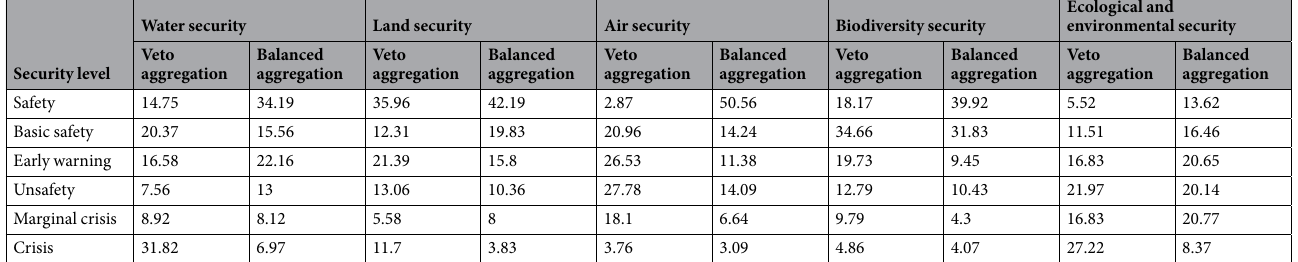
aggregation and 71.75% by the balanced aggregation method (Table 1). Area proportions at the marginal crisis and crisis classes are 9.79% and 4.86% by the veto aggregation, compared to the 4.30% and 4.07% areas by the bal- anced aggregation method (Table 1). Areas at the danger level present a relatively scattered distribution, including the Hengduan Mountains in southwestern China, hills in southern Yunnan Province, adjacent Mountains of Chongqing Municipality and Hubei Province, adjacent Mountains of Zhejiang Province and Fujian Province, the Nanling Mountains in southeastern China. Ecological and environmental security evaluation. Figure 2 shows the final ecological and environ- mental security evaluation in terrestrial ecosystems of China. With different strategies and emphases of two meth- ods, different numerical values and spatial distribution of evaluation results are shown. The veto aggregation score yielded a mean value of 4.83 and a standard deviation of 1.13, ranging from 1.00 to 6.00. In contrast, the balanced aggregation score yielded a mean value of 2.19 and a standard deviation of 0.51, ranging from 1.00 to 4.03. Areas at the danger level are the highest, which accounted for 43.05% of the total evaluation area by the veto aggregation method. In contrast, areas at the insecurity level are the highest by indication of the balanced aggregation method, which accounted for 40.79% of the total evaluation area (Table 1). Moreover, the evaluation scores by the veto aggregation method which are larger than 4.00 and 5.00 accounted for 70.09% and 44.00% of the evaluation area, which means that at least one security evaluation indicator is up to the crisis and marginal crisis classes in 70.09% and 44.00% of the evaluation area, respectively. Only 16.03% and 30.08% by the veto aggregation and balanced aggregation methods of the evaluation areas were classified to the security level. Additionally, the insecure ecolog- ical and environmental areas, including the non-evaluation (extreme of degradation and cannot support human survival and development), insecurity level and danger level, account for 84.52% and 72.85% of the national ter- ritorial area by the veto aggregation method and the balanced aggregation method, respectively. Both of the two aggregation methods showed a relatively serious ecological and environmental security crisis in China. Integrating diverse spatial distribution of four aspects for the final ecological and environmental security evaluation, both the aggregation methods presented an obviously spatial variation of the security evaluation results (Fig. 2). The result showed that areas at the security level are mostly located in the Tibet Plateau, Tianshan Mountains and Altai Mountains in northwestern China, the Great Khingan Mountains in northeastern China,